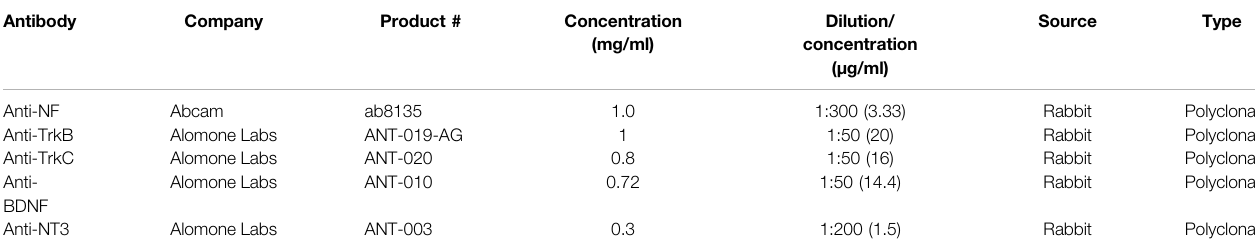
TABLE 1 | List of primary antibodies used for immunohistochemistry.